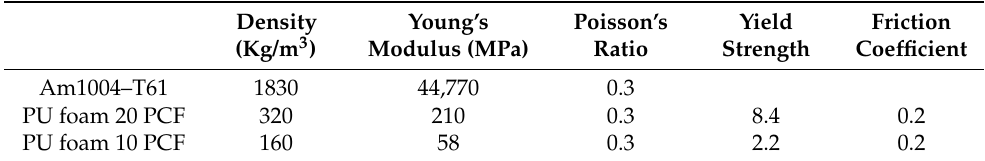
Table 1. Mechanical properties of materials in the FEA